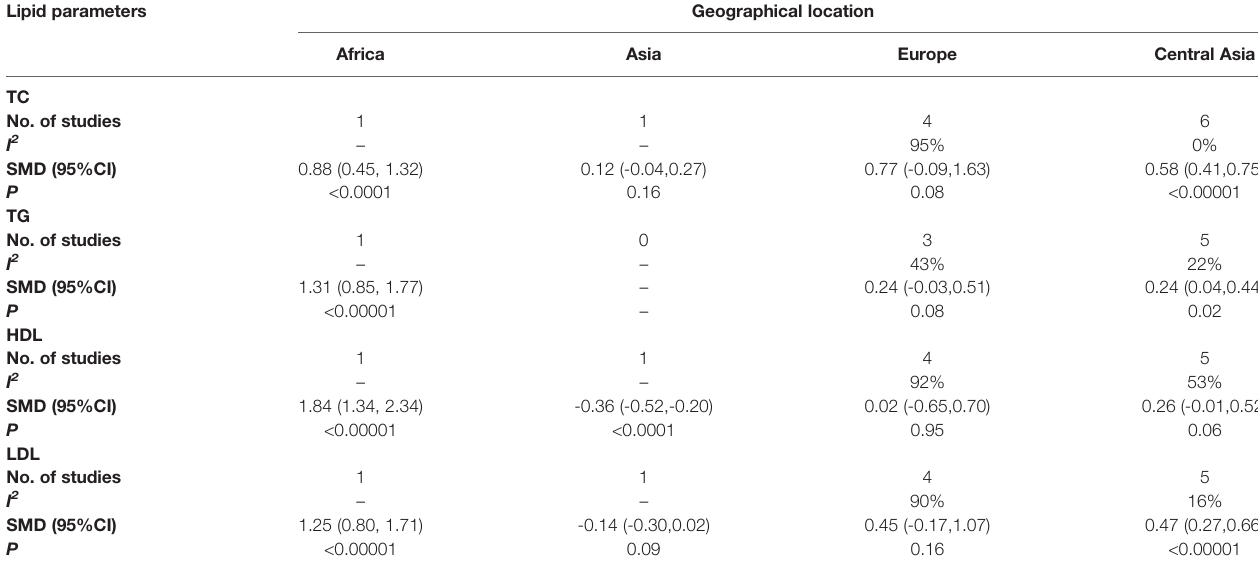
TABLE 2 | Subgroup analysis to investigate the relationship between geographical location and TC, TG, HDL, LDL. Lipid